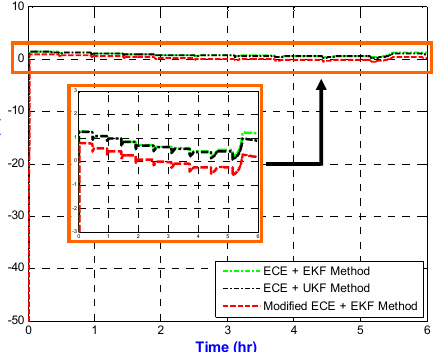
Figure 15. SOC estimation error under discharge in Experiment